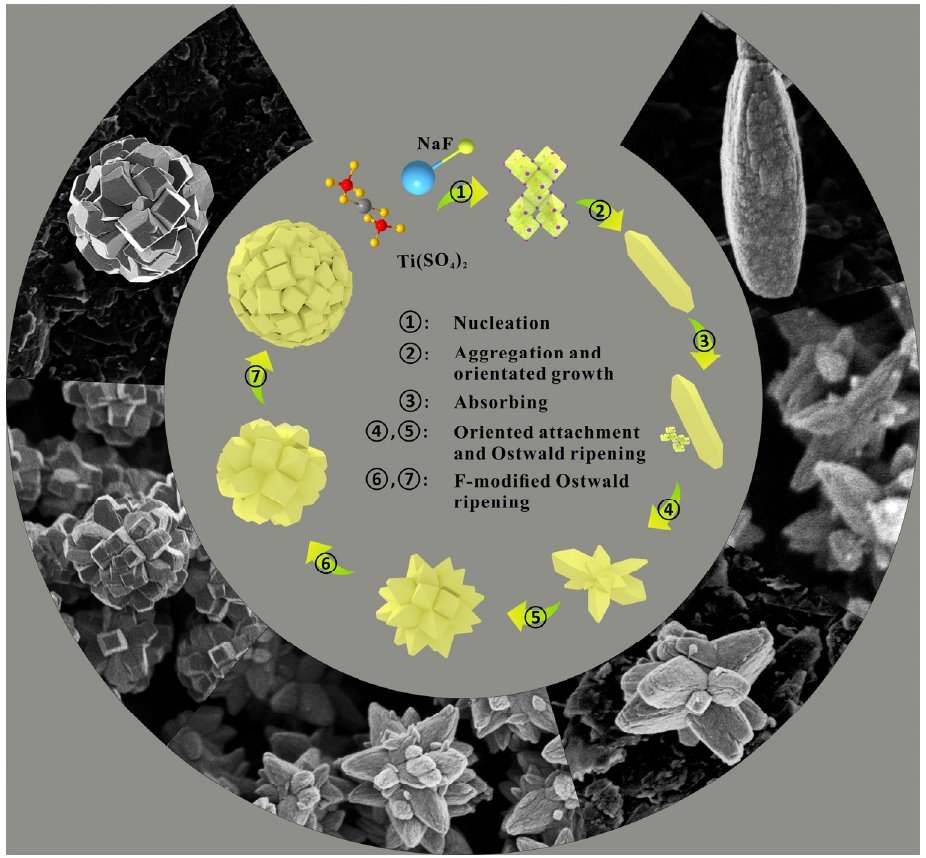
Figure 5. The formation mechanism of microspheres.